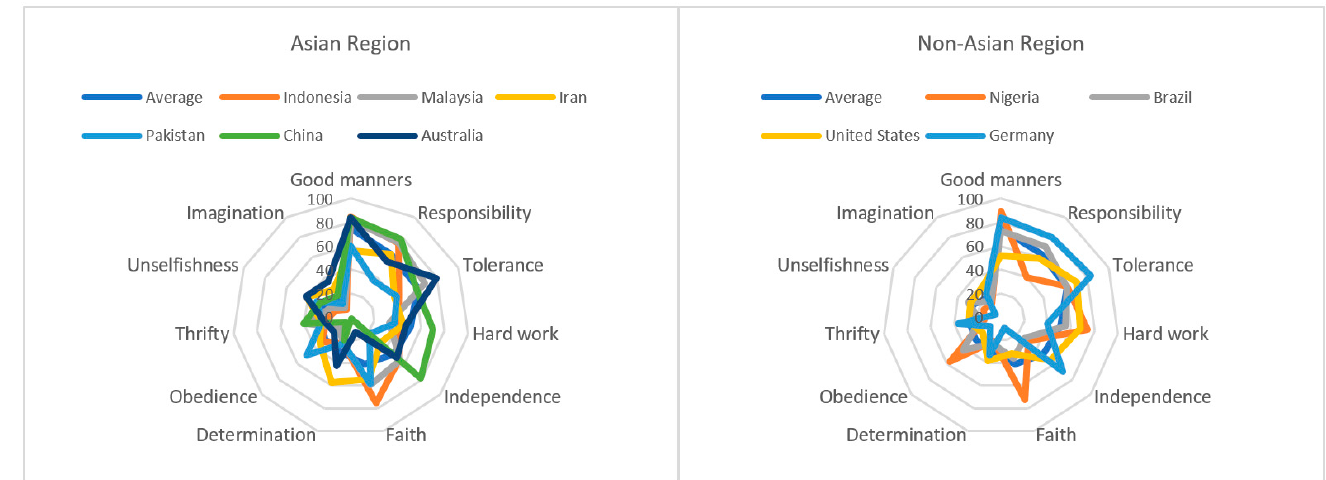
Future Internet 2021 , 13 , x FOR PEER REVIEW Figure 6. Qualities to develop for future generation by Asian and Non-Asian regions.